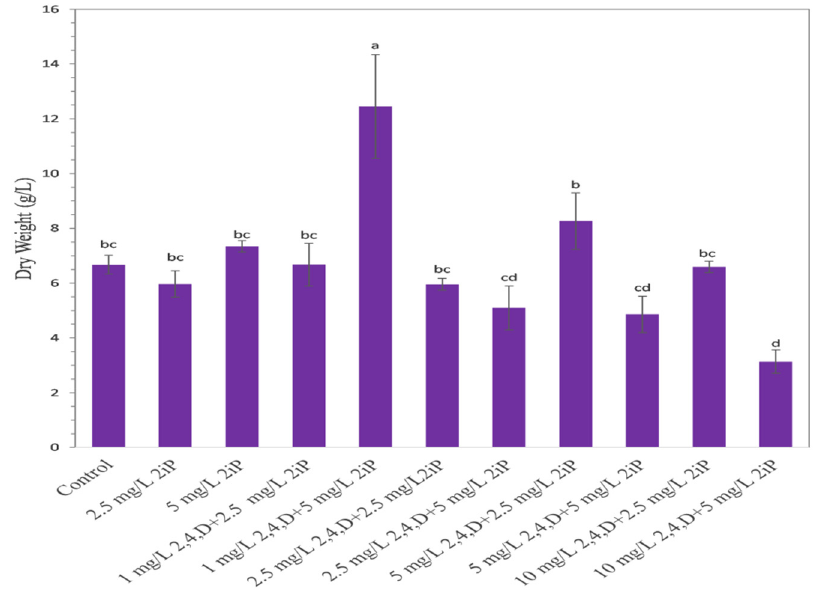
Figure 3. Effect of 2iP and 2,4-D on dry weight (g/L) in date palm cell suspension culture. At the eleventh week of culture, data were recorded. Line bar represents the SE. The same letters indicate no significant difference according to DMRT ( p ≤ 0.05).